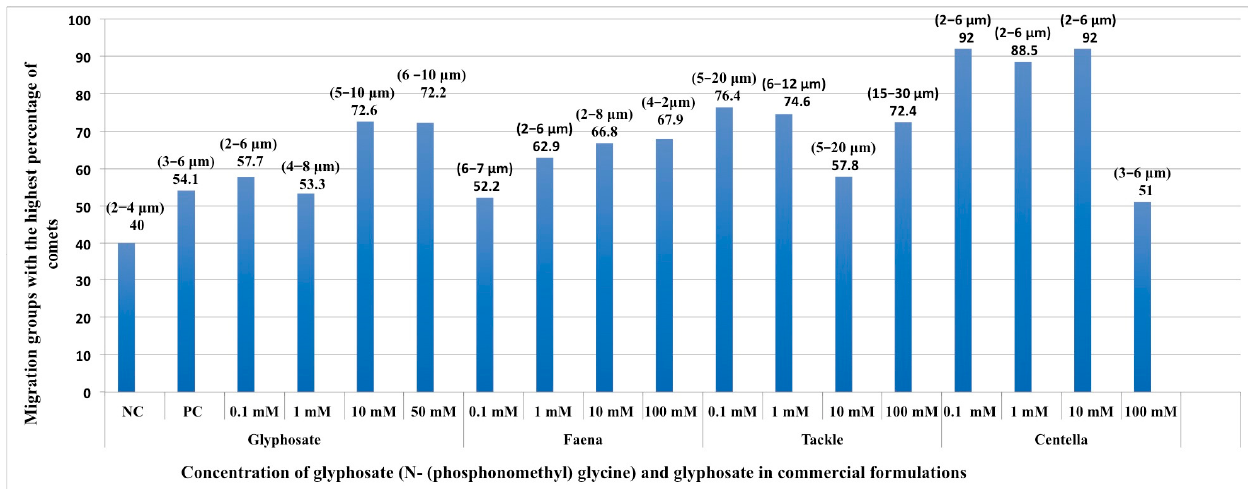
Figure 3. Migration groups parameter. Genetic damage in blood cells exposed to different concentrations of G and in three commercial formulations; the most frequent migration group observed for each evaluated substance is shown. NC, negative control (phosphate buffer), PC, positive control (10 mM EMS).